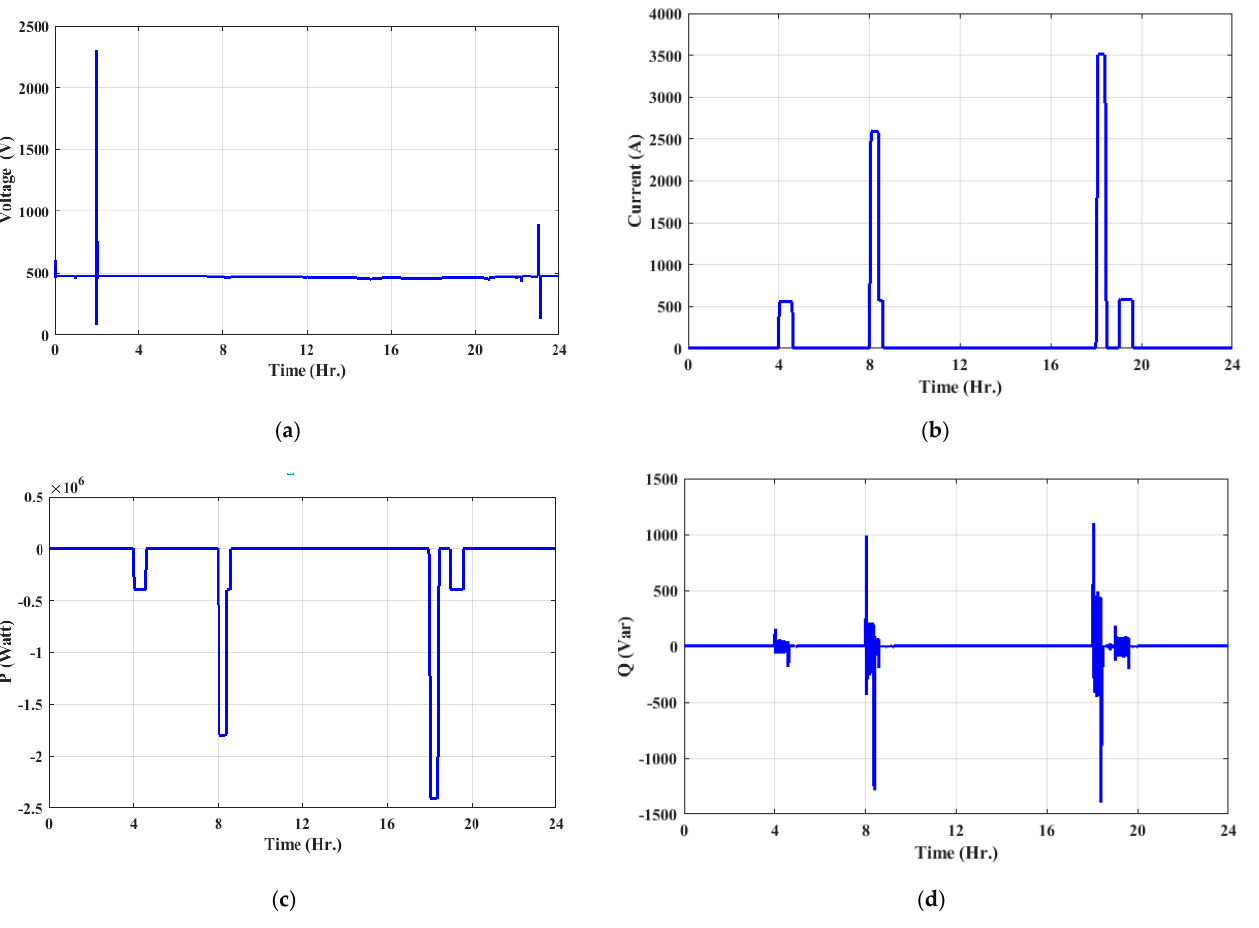
Figure 17. Parameters of EV: ( a ) voltage, ( b ) current, ( c ) active power, and ( d ) reactive power.